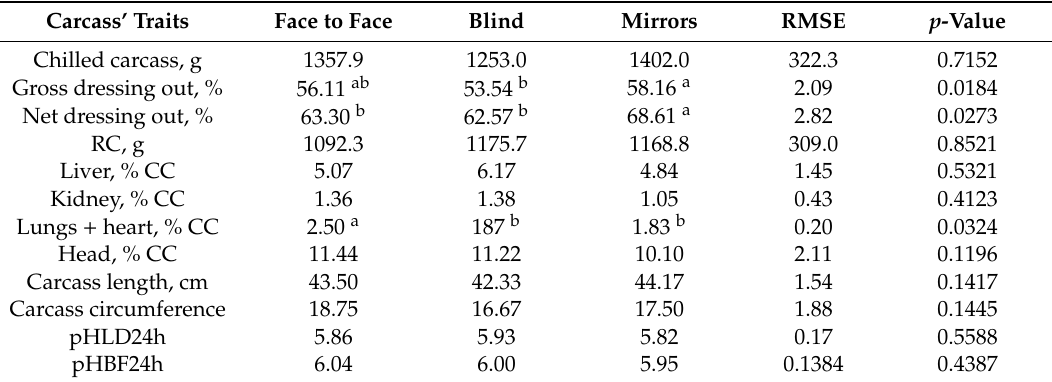
Table 4. E ff ect of housing systems on chilled carcass traits (after 24 h of refrigeration at 4 ◦ C). Carcass’ Traits Face to Face Blind Mirrors